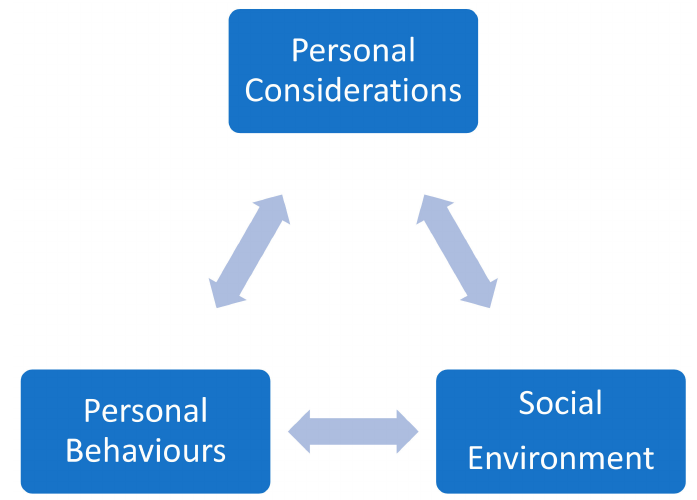
Figure 1. Bandura’s Triadic Reciprocal Causation Model